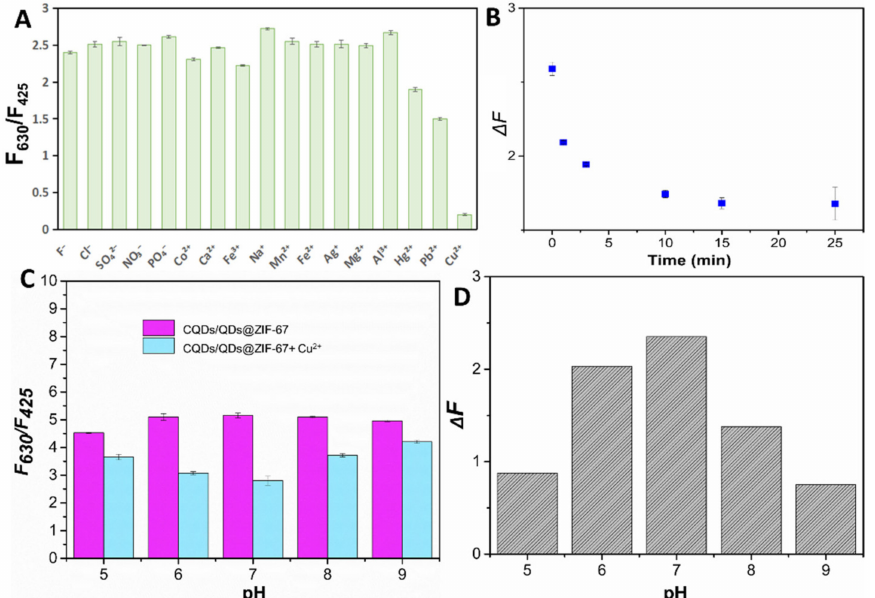
Figure 4. ( A ) The specificity evaluation of the CQDs/QDs@ZIF-67 composite; ( B ) effect of incubation time; ( C ) fluorescence responses of CQDs/QDs@ZIF-67 in the absence and presence of Cu 2+ at different pH; ( D ) the quenching efficiency of fluorescence